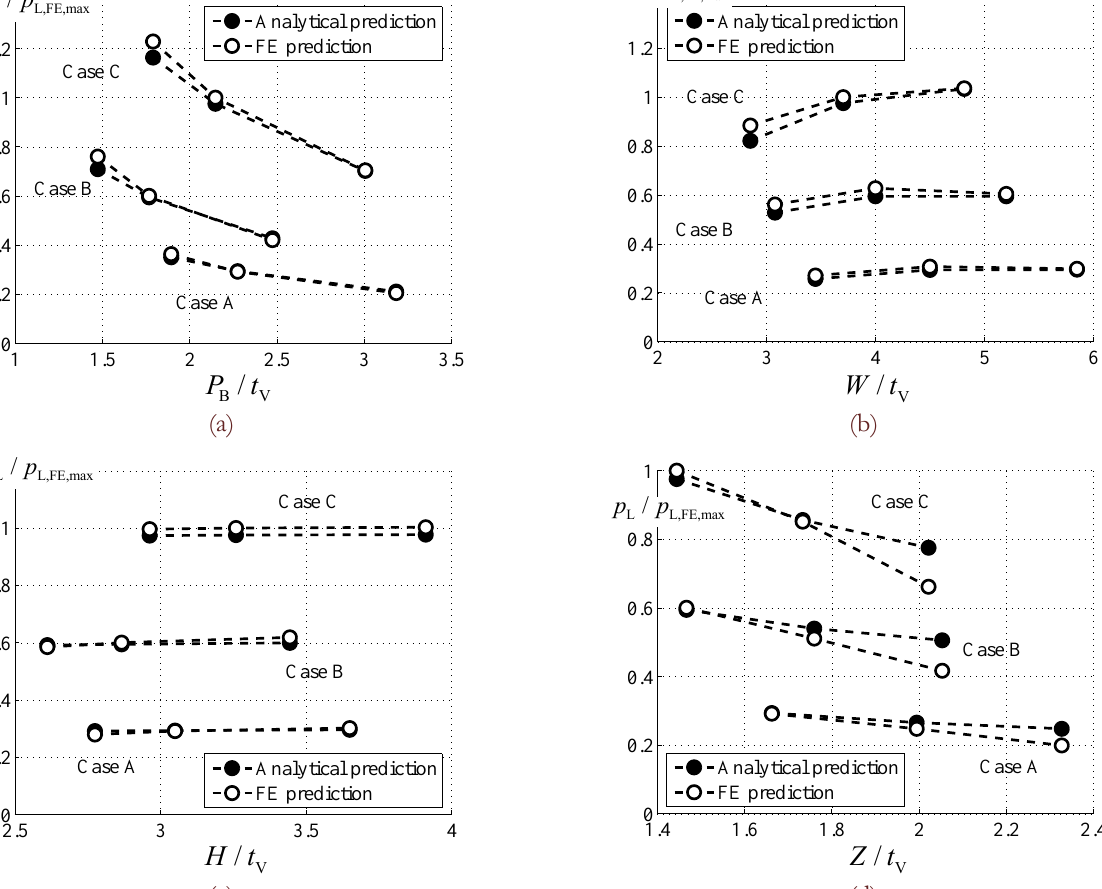
Figura 12. Sensibilità della pressione di contatto ai principali parametri geometrici: (a) passo assiale dei bulloni, (b) larghezza della superficie di contatto della flangia, (c) altezza della flangia, (d) posizione dell’asse del